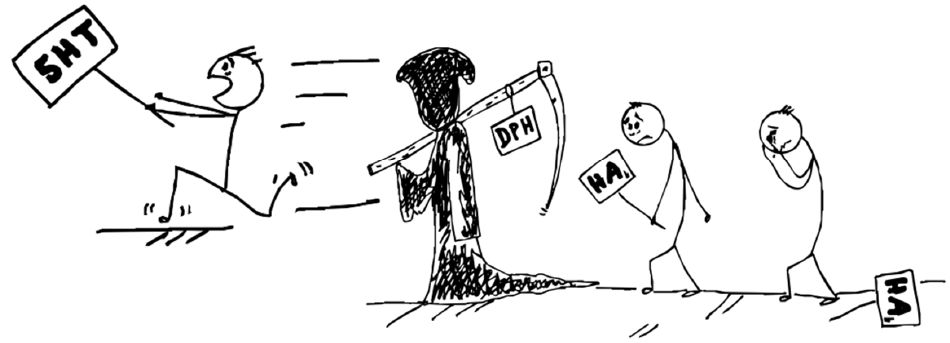
Figure 5. A comic strip illustration of DPH effects on histamine and serotonin.